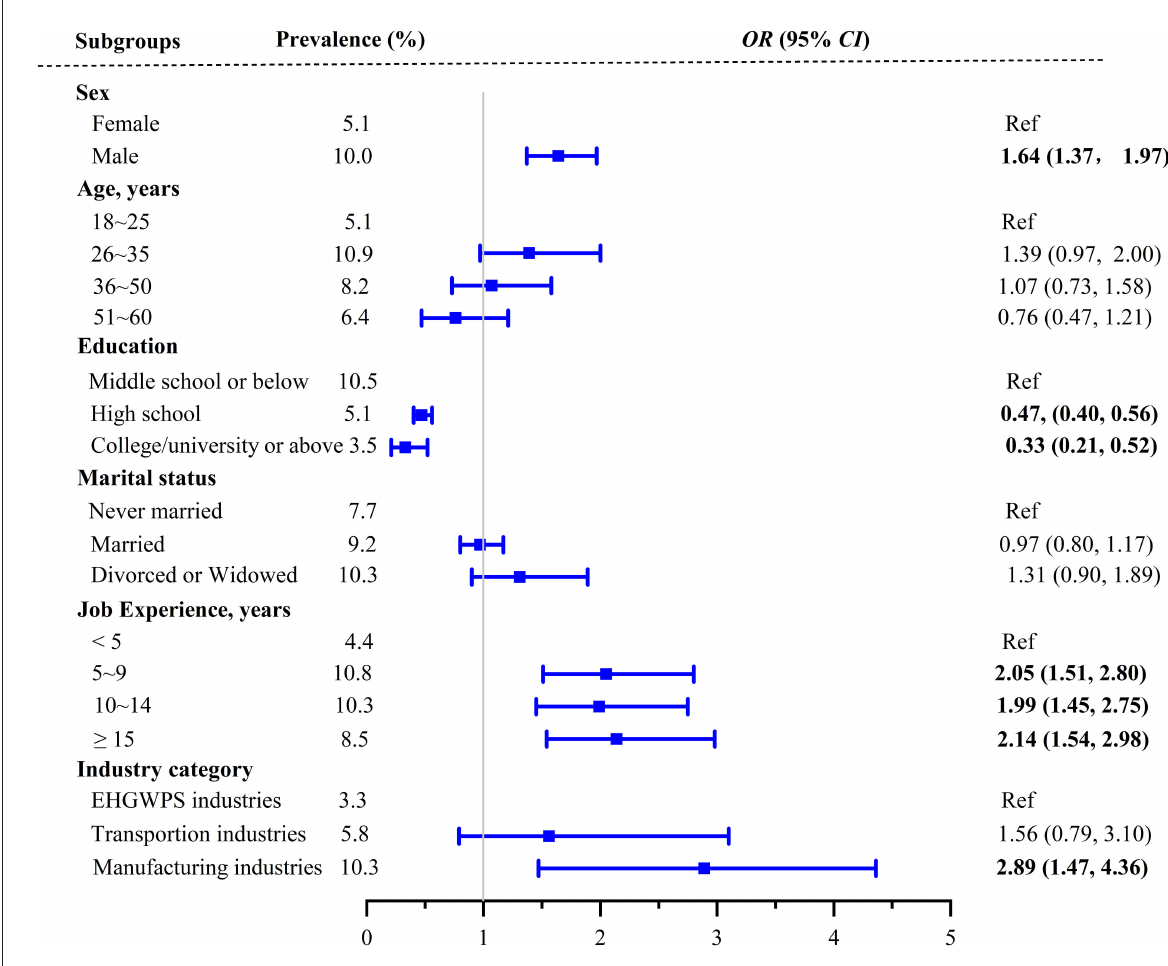
FIGURE2 Association between factors and high occupational stress status.